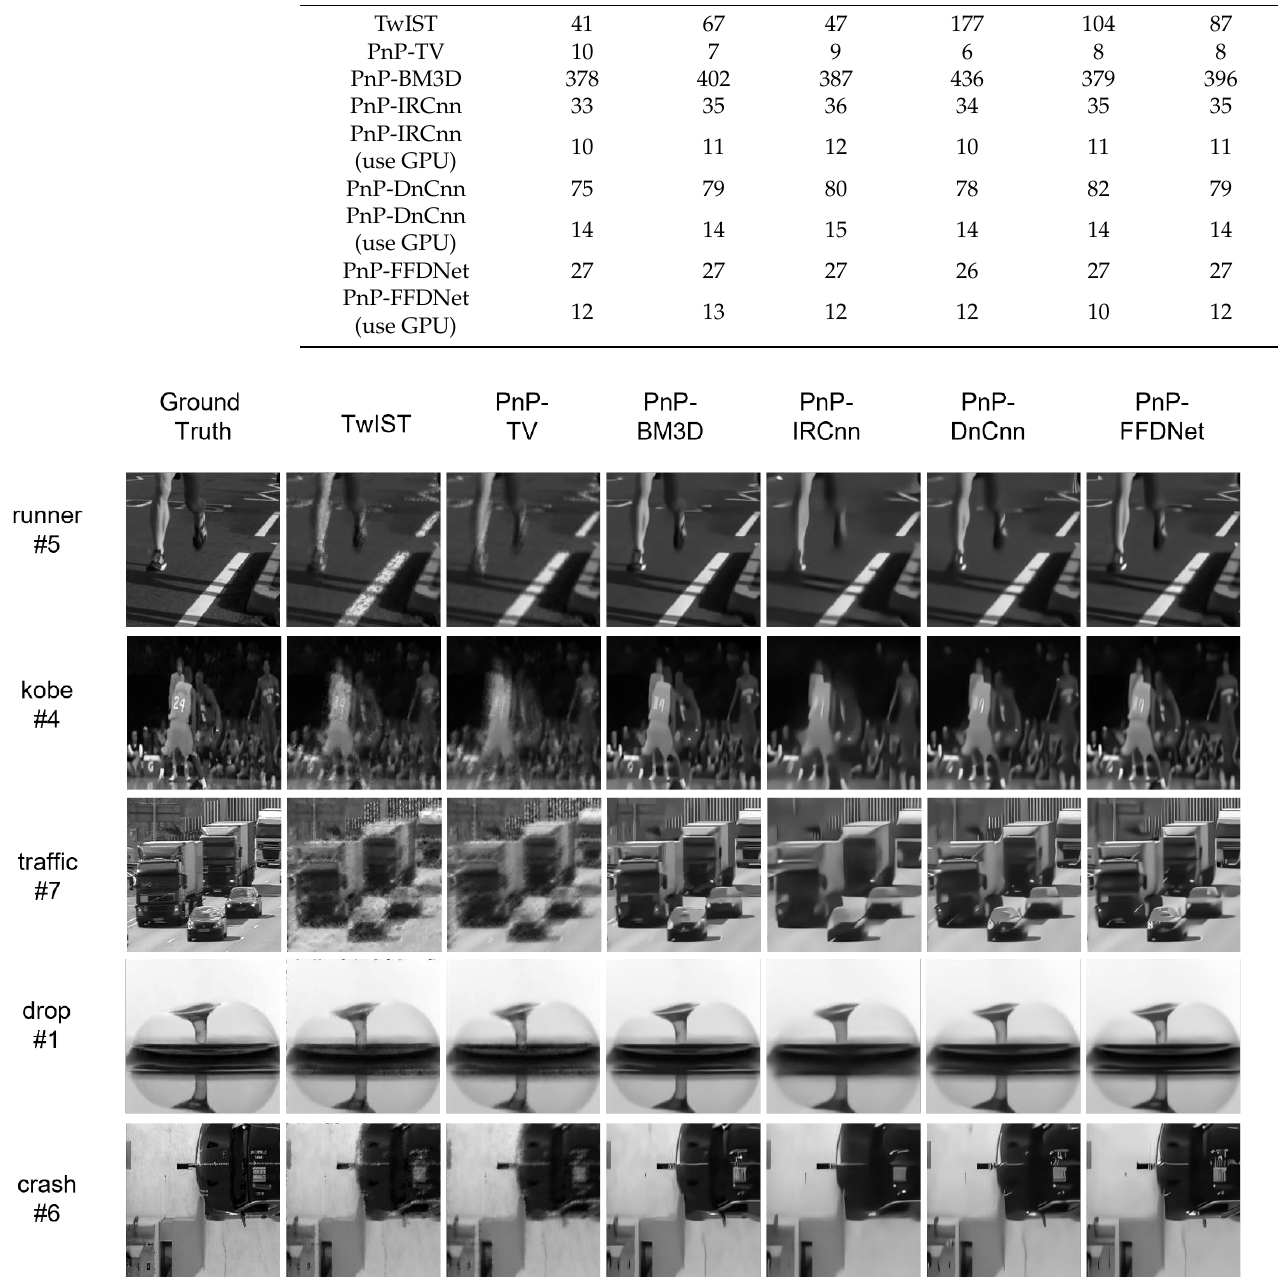
Figure 8. Reconstruction performance of different reconstruction algorithms.